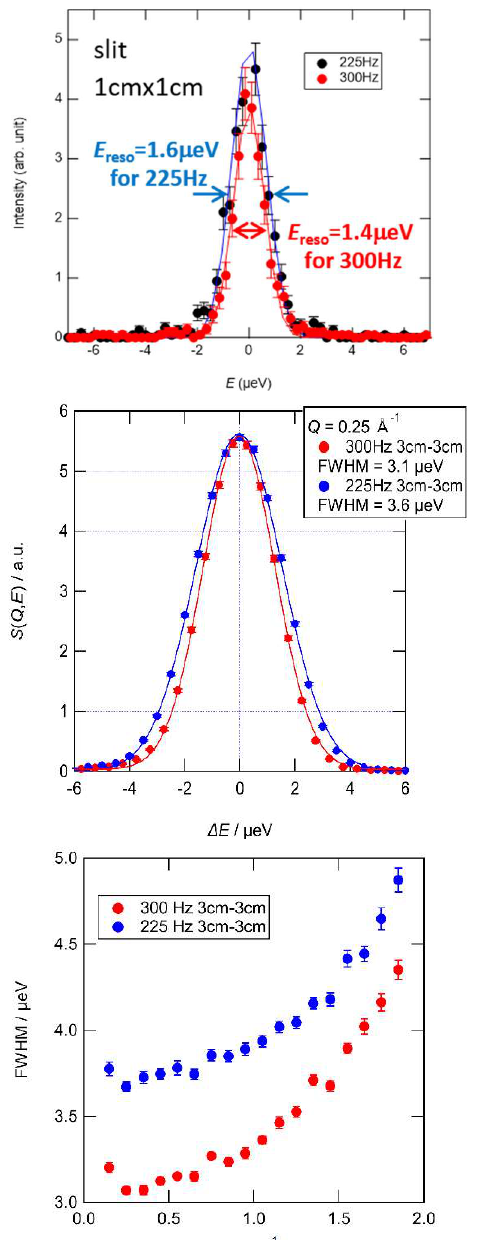
Fig. 1. The energy resolutions of Si111 analyzer mirrors under the highest-resolution condition of the sample size of 1 cm (D) × 1 cm (H) with the slit size of 1 cm × 1 cm (top) and the conventional condition of the sample size of 1.4 cm (D) × 4 cm (H) with the slit size of 3 cm × 3 cm (middle). The Q - dependences of the energy resolutions for these conditions are compared in the bottom.